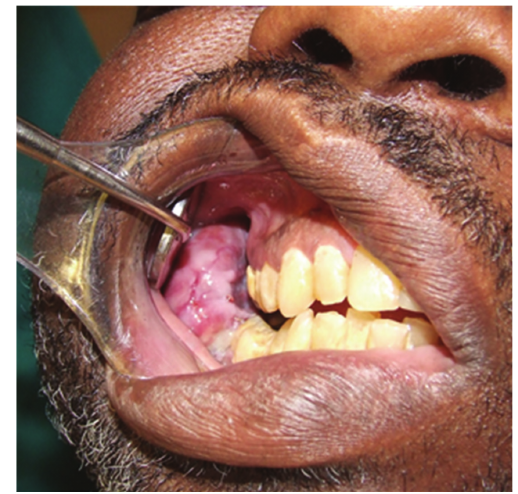
Figure 2: Intraoral expansion of the mandible.